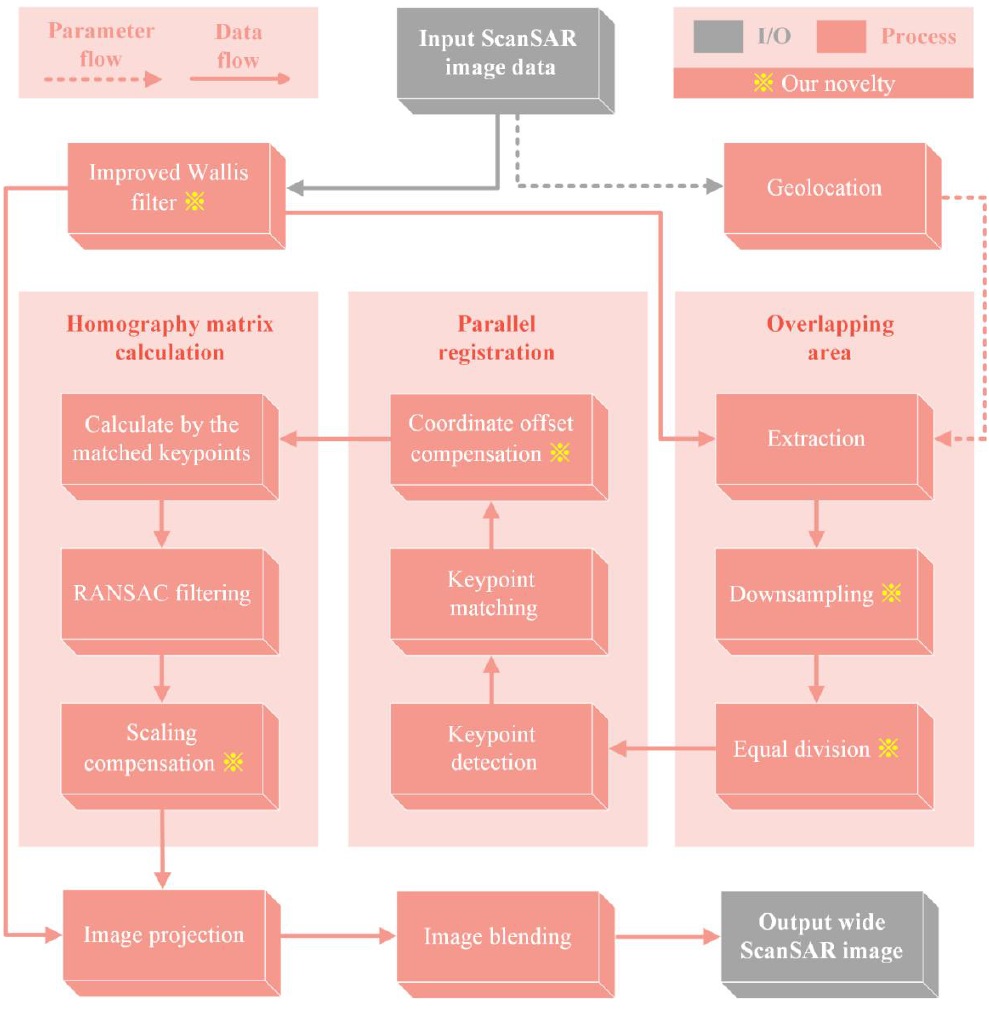
Figure 7. Workflow of the proposed method.